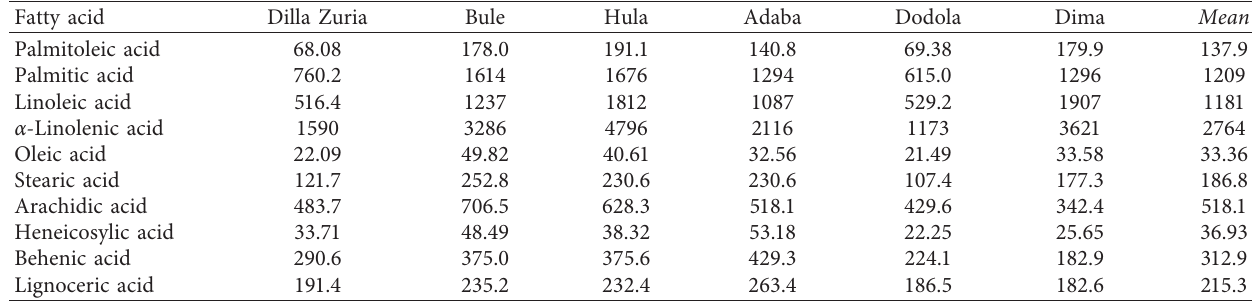
Table 4: The concentrations (mg kg − 1 dry weight) of the fatty acids determined in the leaves of Urtica simensis grown in different locations in